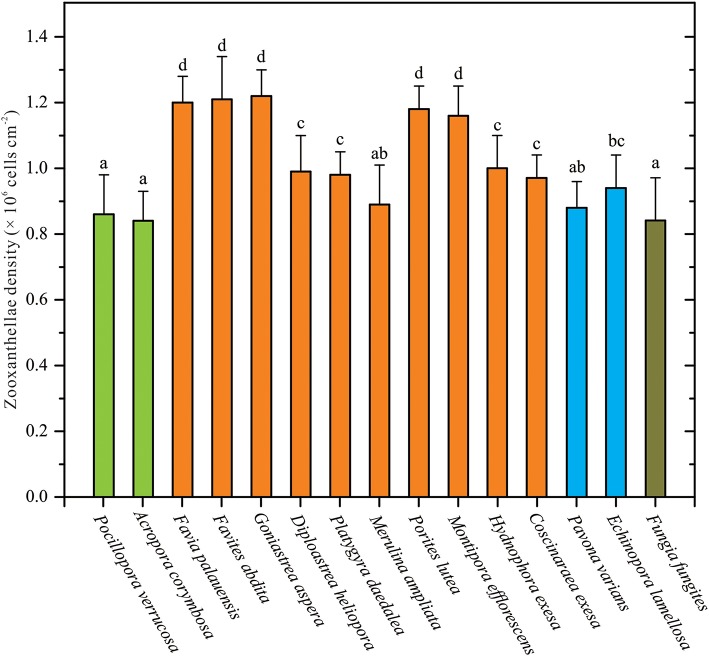
Corals' species-specific differences in zooxanthellae densities (ZDs). ZD data are given as mean ± SD. Letters above histograms denote statistical differences among these 15 coral species (Student-Newman-Keuls multiple range tests, p < 0.05). The colors of bars are meaning different coral morphologies, i.e., green bars meaning branching corals (Pocillopora verrucosa and Acropora corymbosa), orange-yellow bars meaning massive corals (e.g., Favia palauensis, Porites lutea), sky-blue bars meaning plating corals (Pavona varians and Echinopora lamellosa), and cyan bars meaning solitary corals (Fungia fungites).